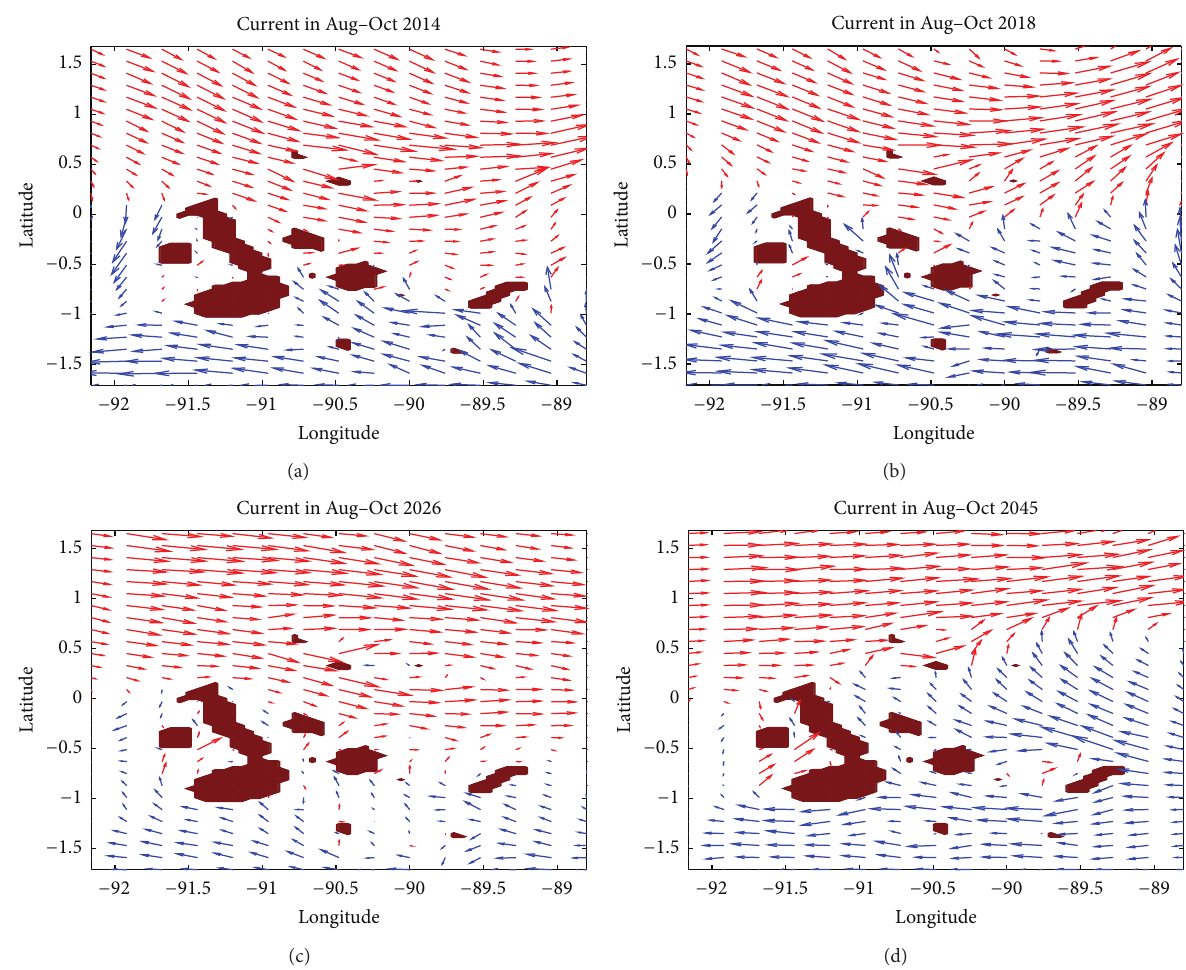
Figure 12: The surface current around the GMR during the La Ni˜na cases: (a) in Aug–Oct in 2014, (b) in Aug–Oct in 2018, (c) in Aug–Oct in 2026, and (d) in Aug–Oct in